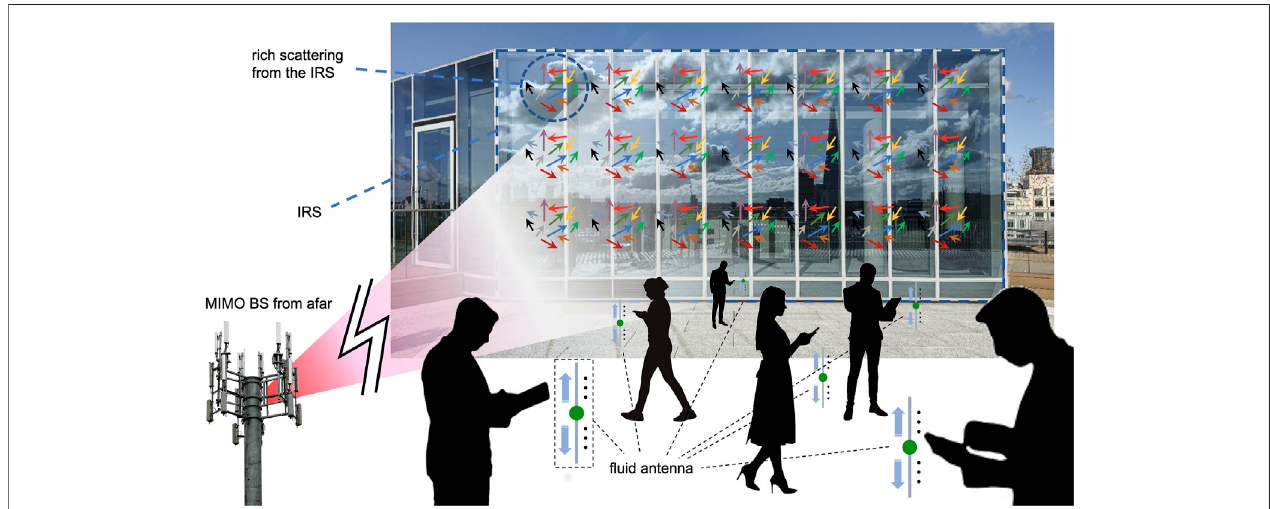
FIGURE 8 | Intelligent Re fl ecting Surface as a large surface of arti fi cial scatterers for FAMA in the downlink.